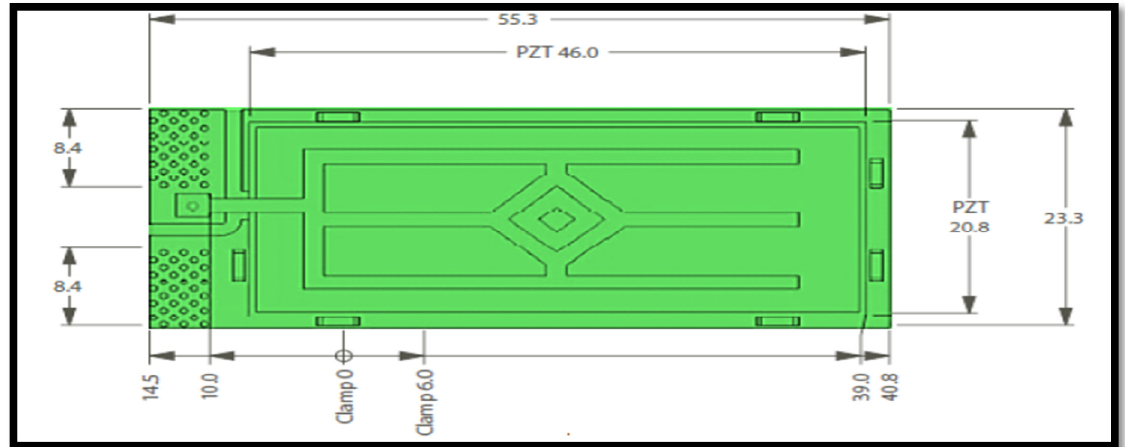
Fig. 3. PPA-1001 transducer with its dimension in